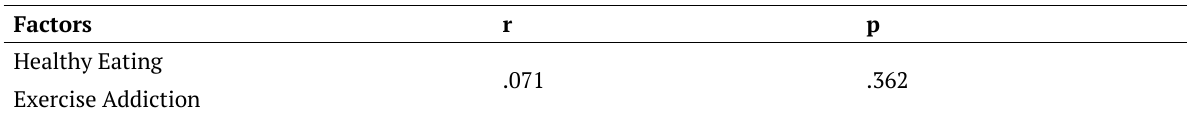
Table 8. Pearson correlation analysis results for association between attitude to healthy eating and exercise addiction